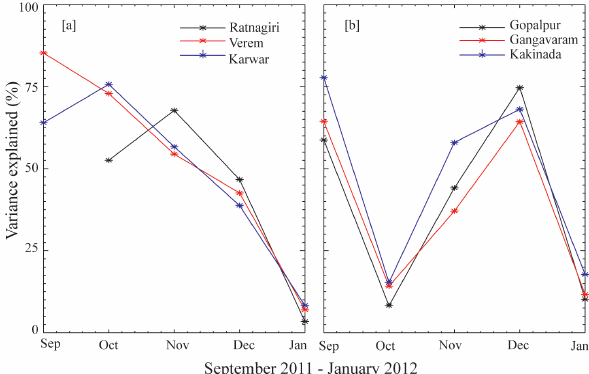
Table 5. The peak response of the daily mean sea level residual (SLR) along with the estimated daily mean SLR during E1 & E2. Measured daily- Estimated mean peak daily mean Difference Station Event SLR (cm) SLR peak (cm) (%) Ratnagiri E1 29.6 28.5 3.7 Verem E1 25.8 27.4 − 6.5 Karwar E1 27.7 Gopalpur E2 Gangavaram Kakinada